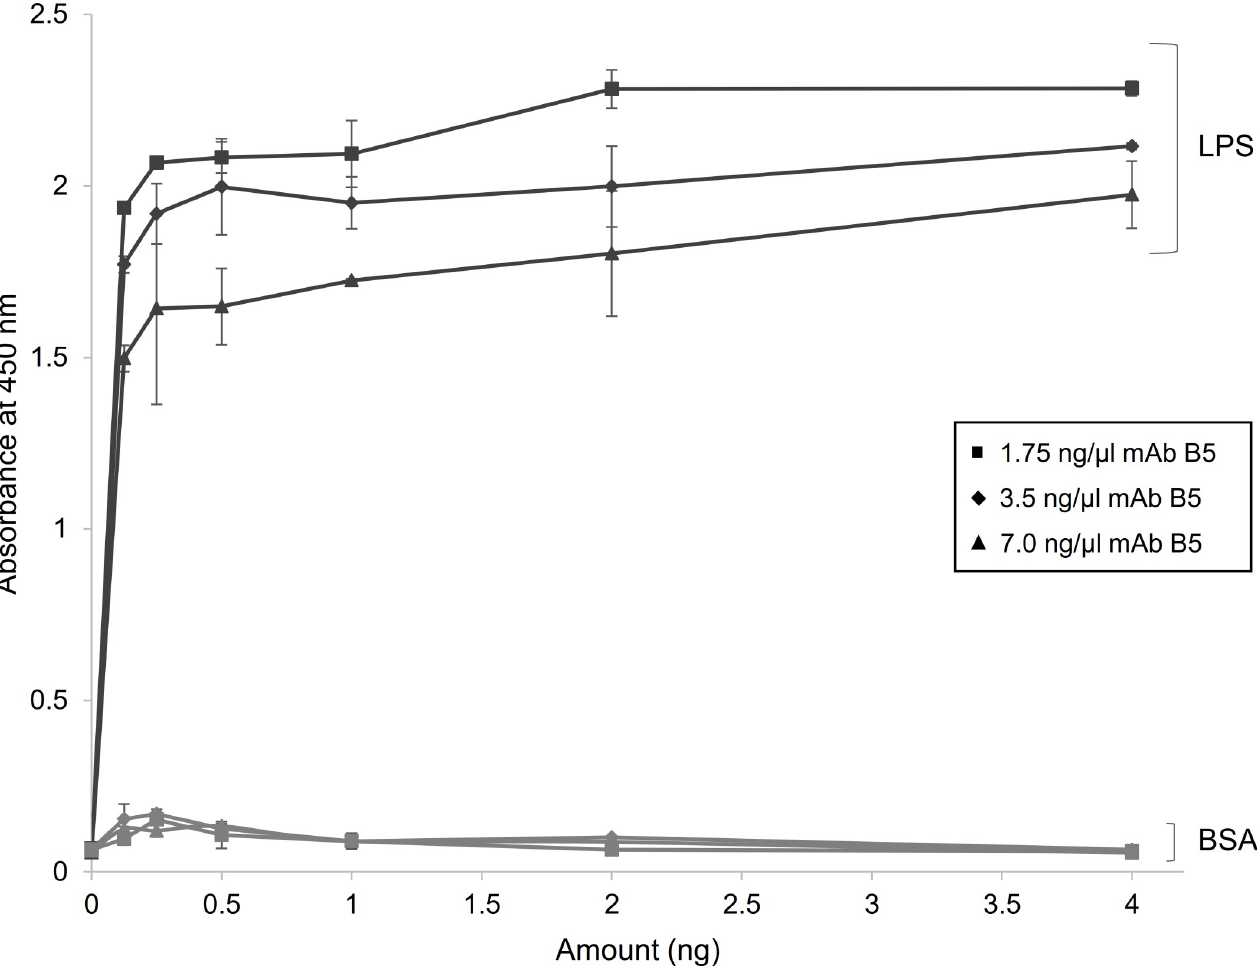
Fig 2. Specificity and optimization of anti-LPS B5. The specificity and optimal concentration of the mouse monoclonal anti-LPS antibody (mAb) B5 produced in this study was determined using indirect ELISA with varying amounts of B . mallei lipopolysaccharide (LPS; black lines) or bovine serum albumin (BSA; grey lines), and detecting antigen with varying concentrations (1.75, 3.5, and 7.0 ng/ μ L) of mAb